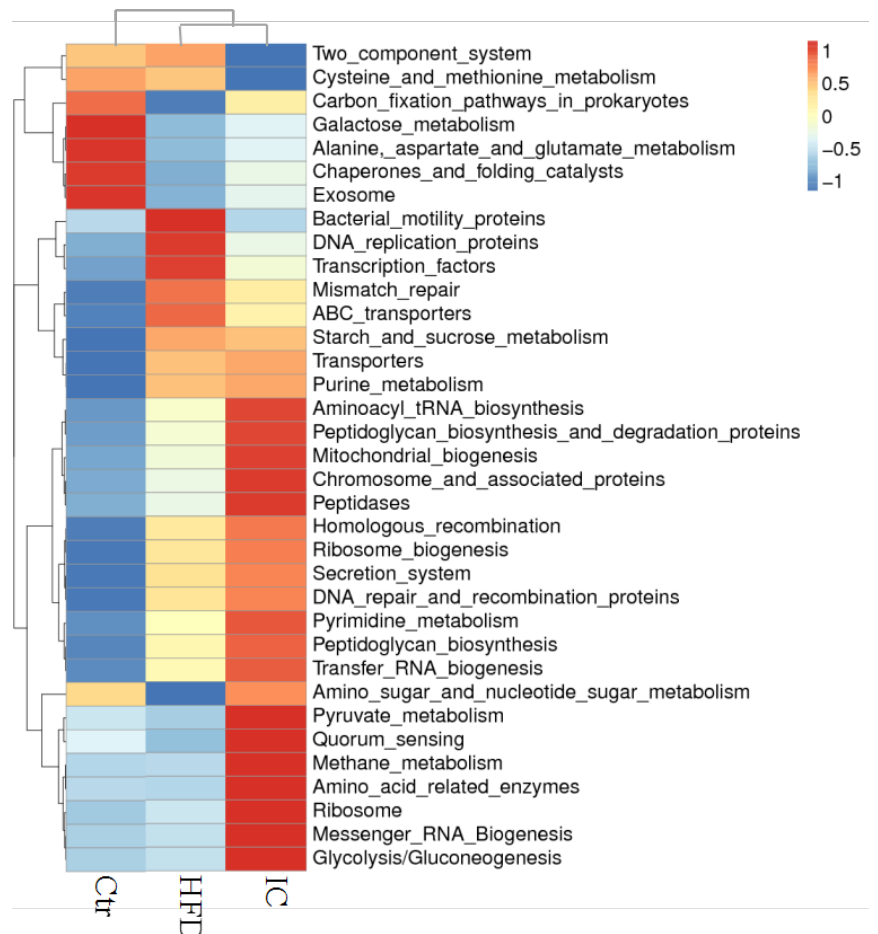
Figure 6. Tax4Fun functional prediction.